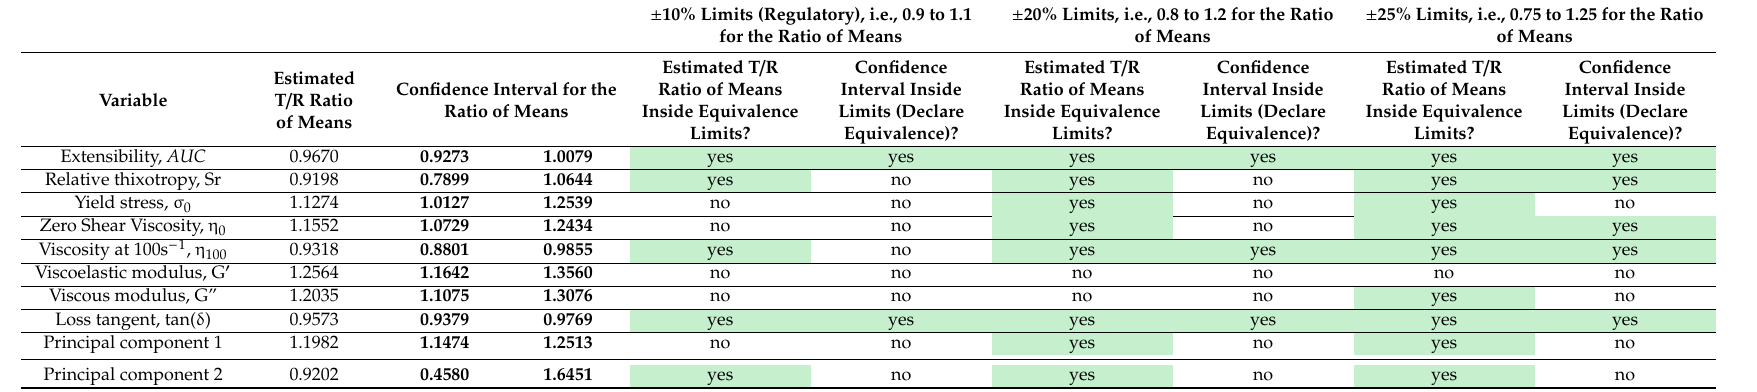
Table 3. Equivalence analysis between two packaging formats of the brand product